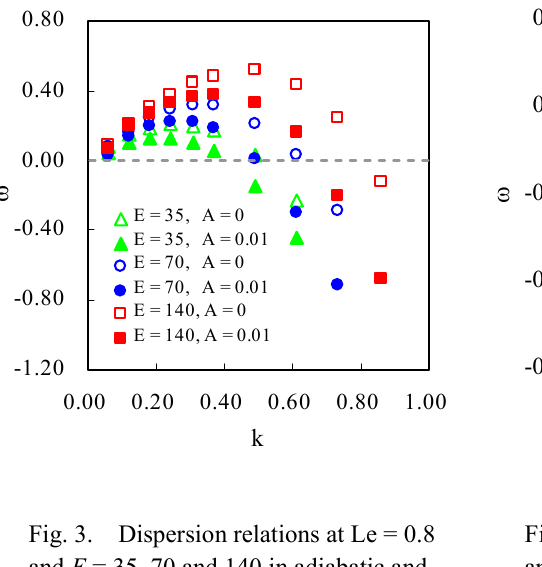
Fig. 3. Dispersion relations at Le = 0.8 Fig. 4. Dispersion relations at Le = 1.2 and E = 35, 70 and 140 in adiabatic and and E = 35, 70 and 140 in adiabatic and non-adiabatic flames. non-adiabatic